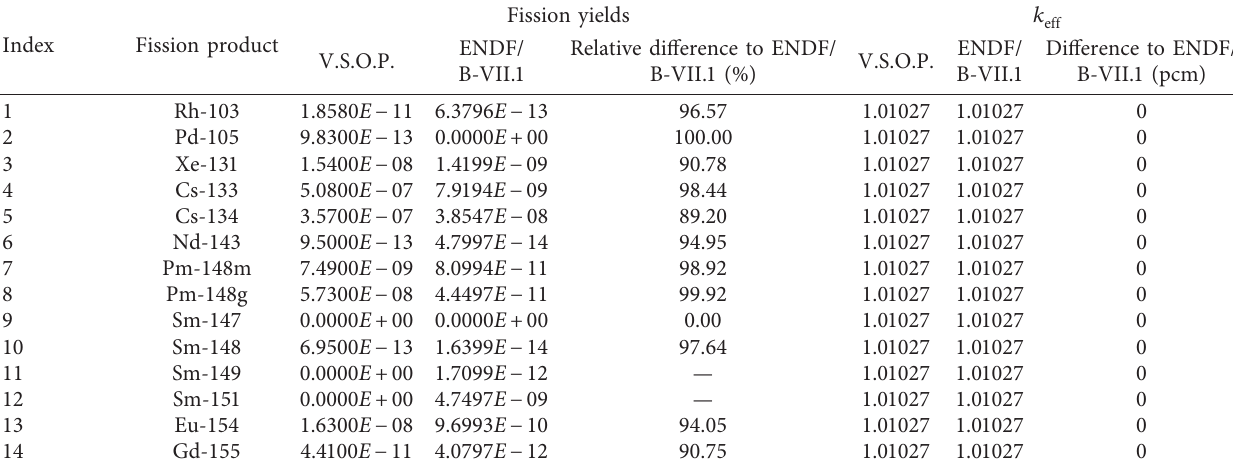
prediction (IFYs). eff